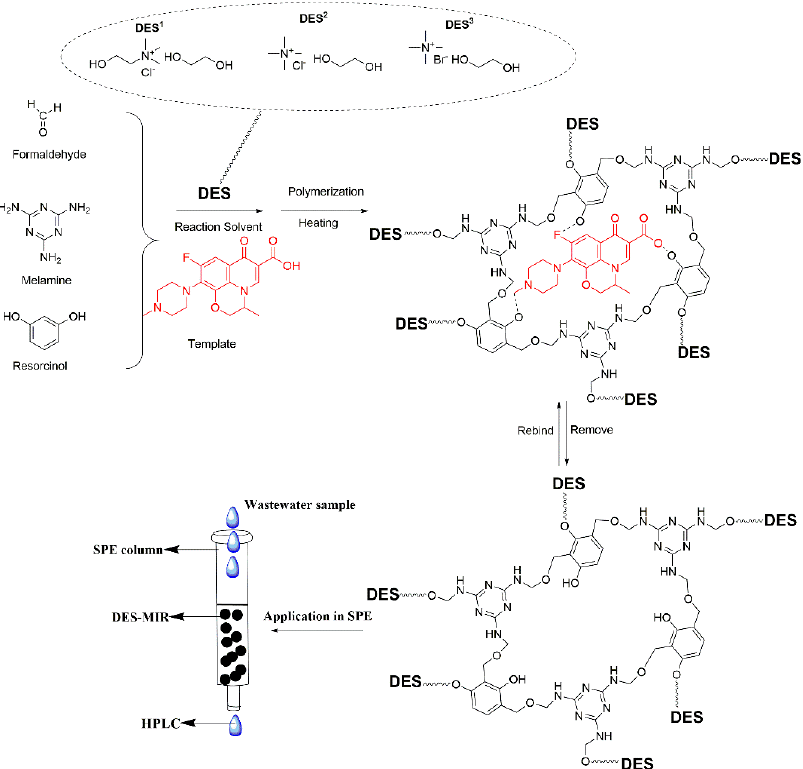
Figure 2. Schematic representation of the fabrication of the DES-MIR and application in solid-phase extraction (SPE). extraction